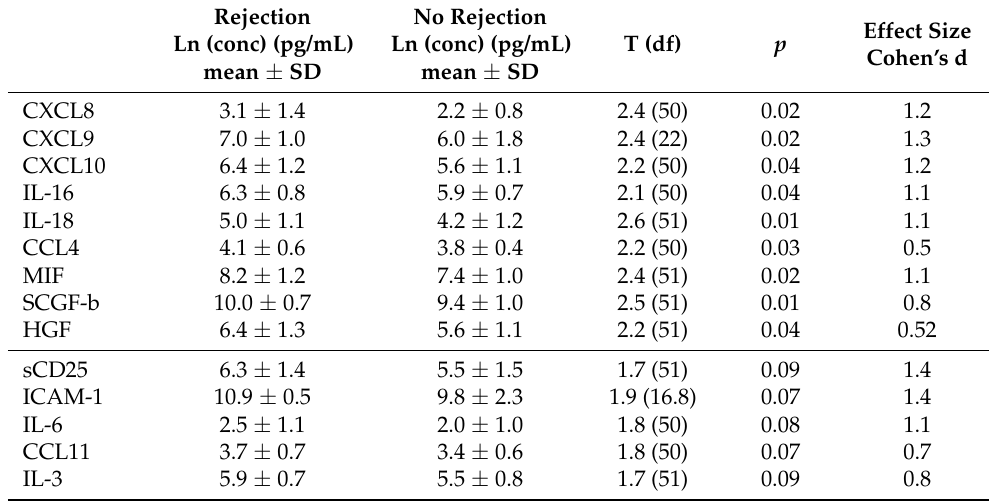
Table 4. Cytokine levels in rejection and non-rejection